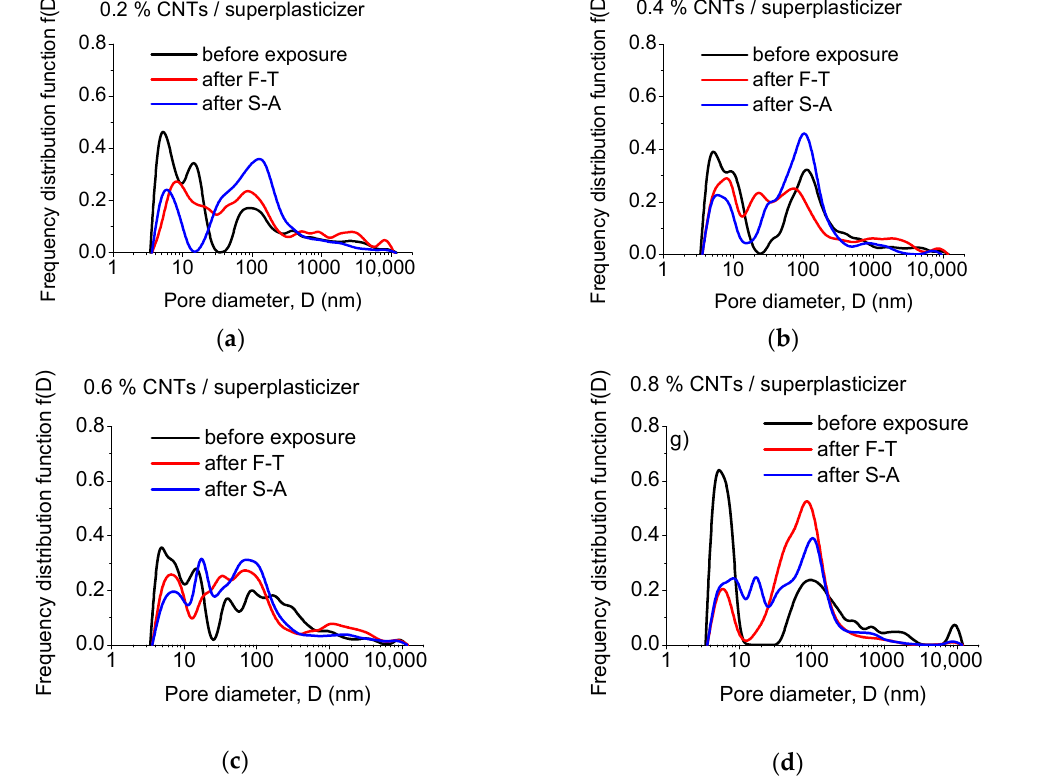
Figure 5. Effect of exposure state on the pore size distribution of mortars with: ( a ) 0.2, ( b ) 0.4, ( c ) 0.6, and ( d ) 0.8 wt.% CNT contents, prepared using superplasticizer as dispersant.